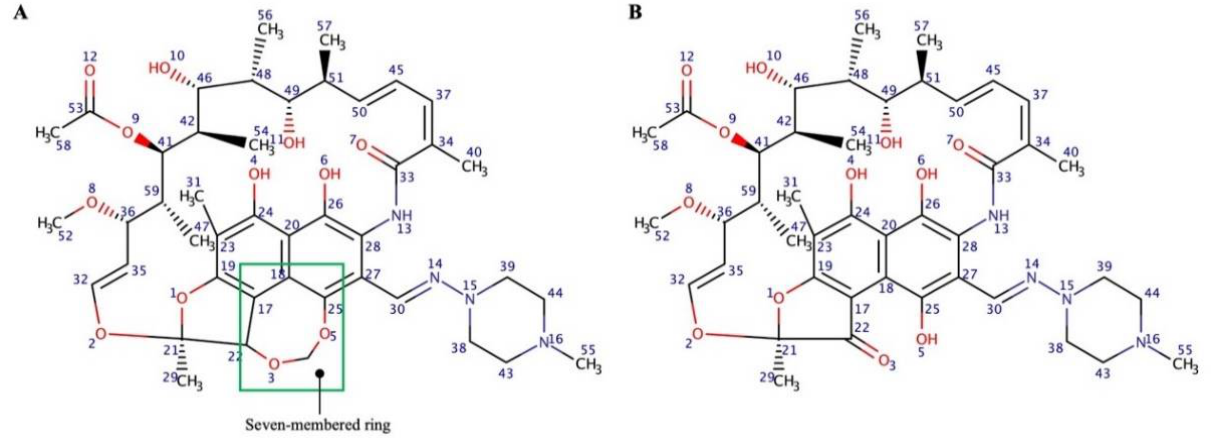
Figure 7. Chemical structure of RIF polymorphism in ( A ) form I and ( B ) form II.